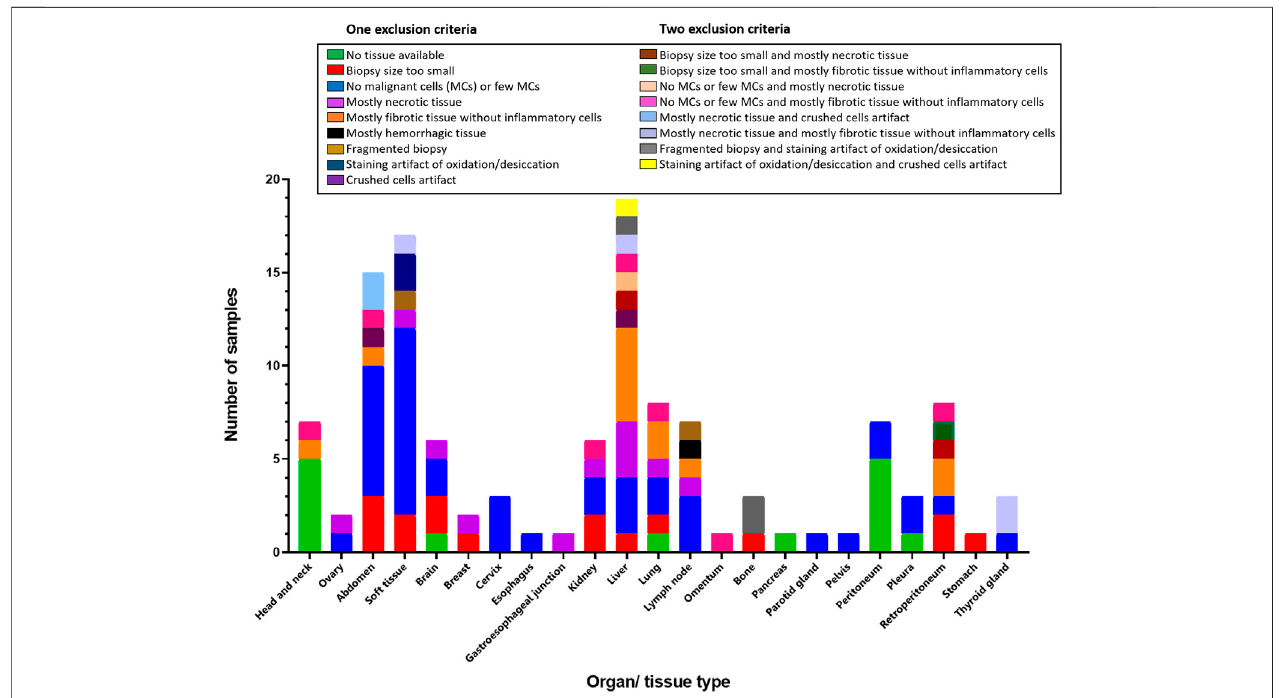
FIGURE 5 | Bar graph showing localization and exclusion criteria of the samples. Inset box containing the exclusion criteria divided in one or two criteria.